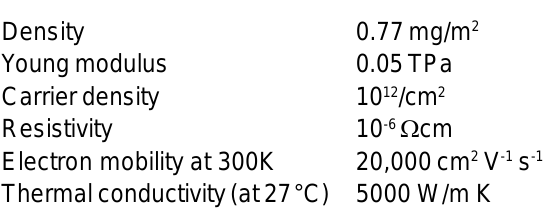
Table 2. General properties of graphene.